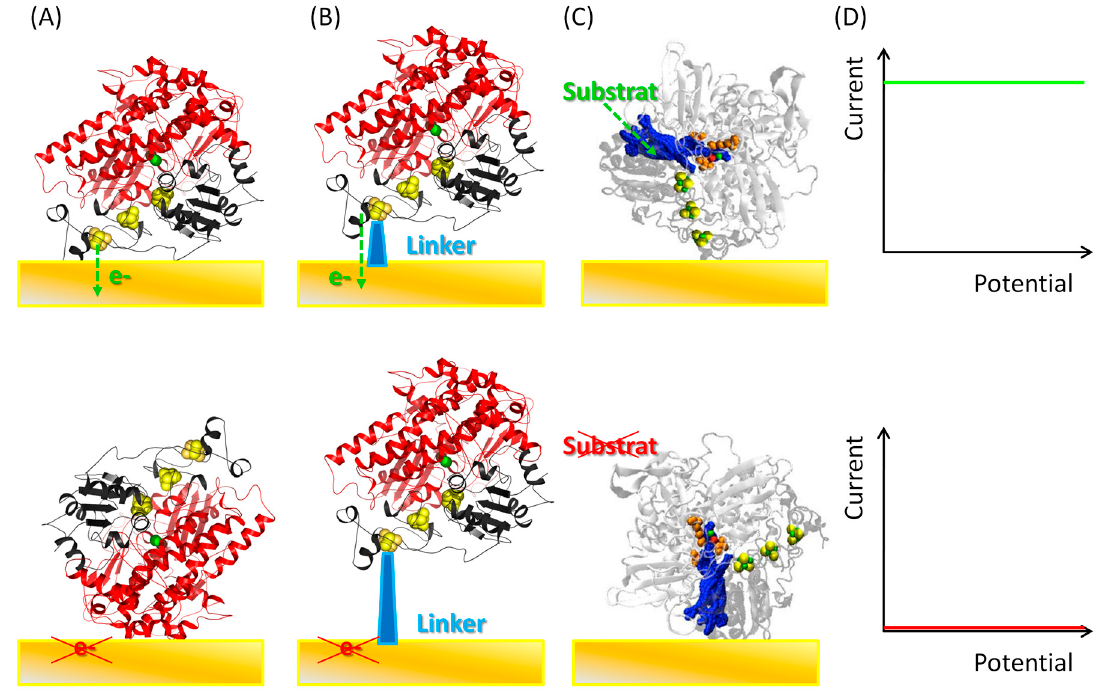
Figure 2. Schemes of enzyme immobilization conditions ( A – C ) allowing or precluding a direct electrical connection (DET) ( D ) at an electrochemical interface. ( A ) Illustrates how the distance between the active site, or a surface electronic relay, of an adsorbed enzyme and the electrode influences DET; ( B ) Illustrates the effect of the length of a linker used for enzyme immobilization on DET; ( C ) Illustrates the effect of the substrate channel access upon enzyme immobilization on